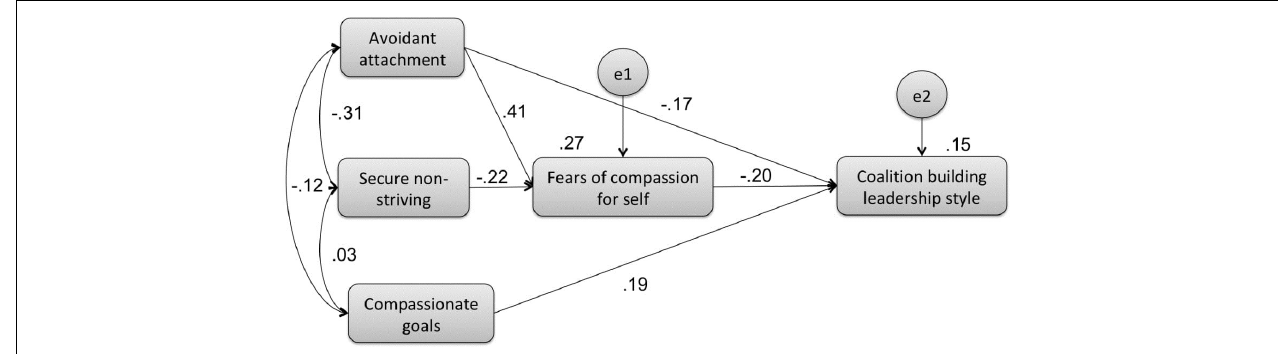
FIGURE 2 | Results of the adjusted model for the mediation path analysis showing the relationships among fears of compassion for self, avoidant attachment, secure non-striving, compassionate goals, and coalition building leadership style.